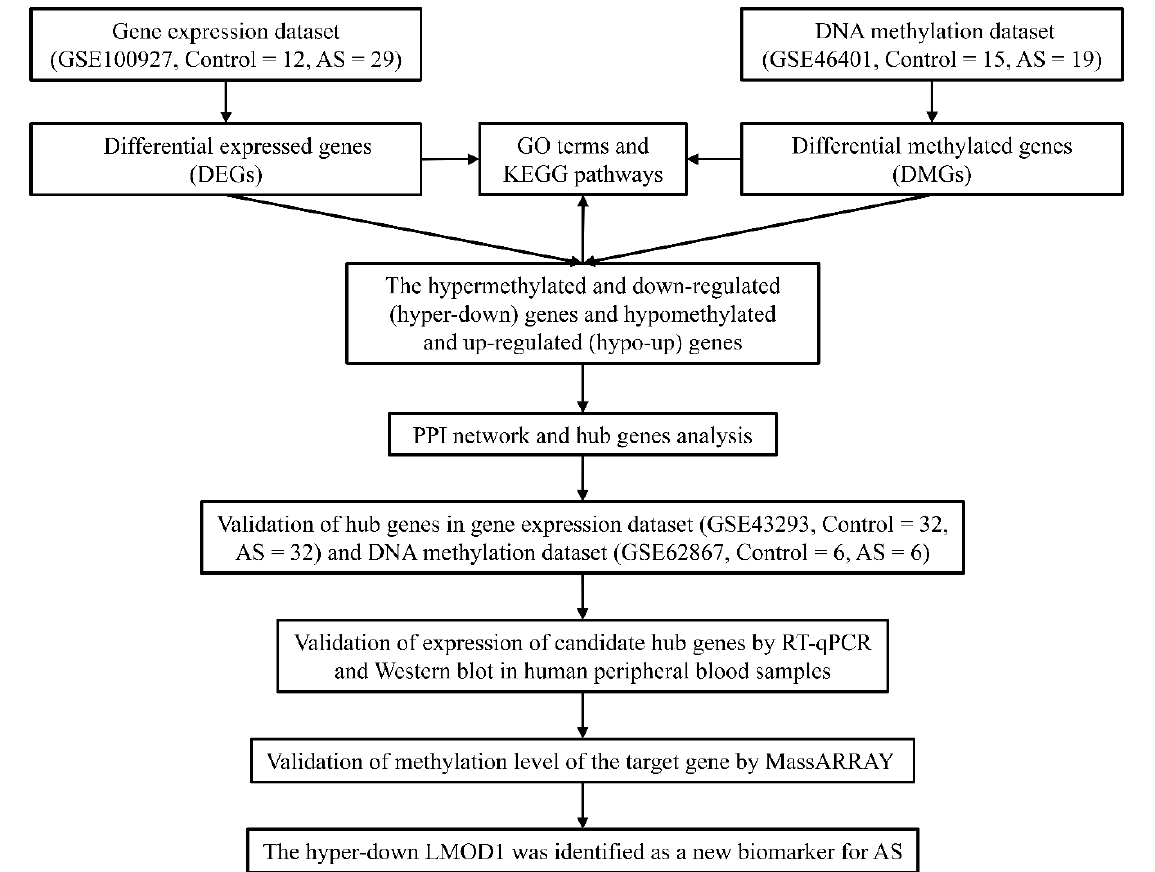
Figure 1. Flowchart of the analysis process.